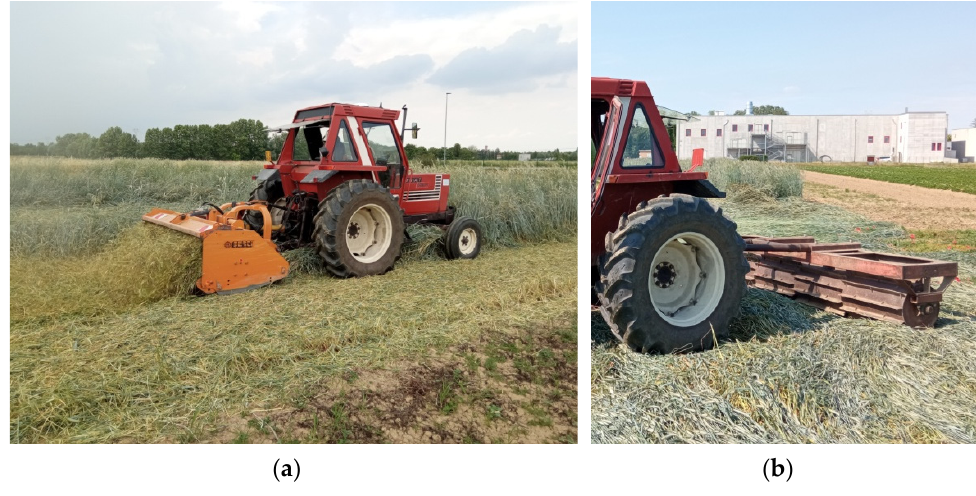
Figure 2. Different cover crop terminations: ( a ) flail mower, ( b ) roller crimper.